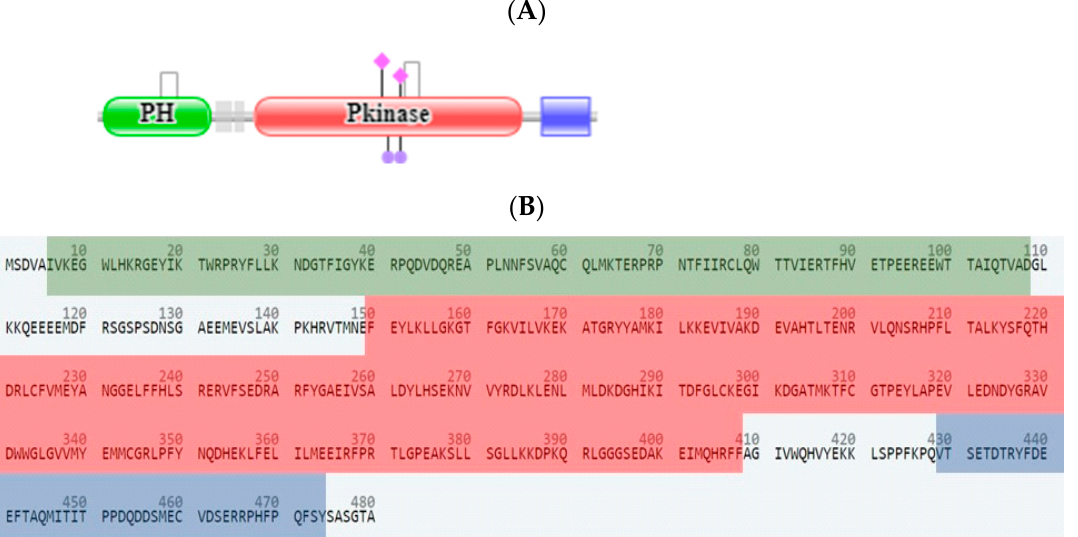
Figure 10. AKT1 protein domains, ( A ) the arrangement of the Pfam domains, ( B ) the FASTA format of AKT1 showing the amino acid residues of 1. Pleckstrin homology domain (green), 2. protein kinase domain (red), 3. protein kinase C terminal domain (blue).